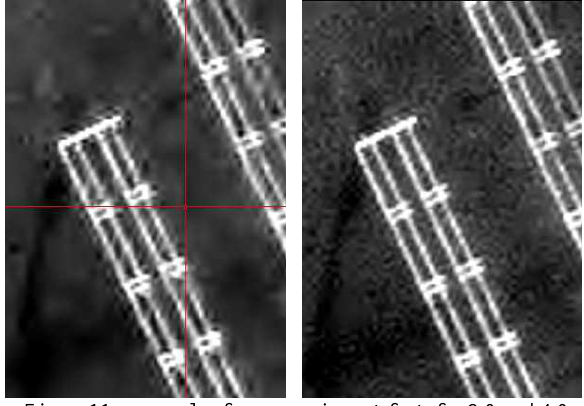
Figure 11 : example of compression artefacts for 2.0 and 4.0 bpp bit rate